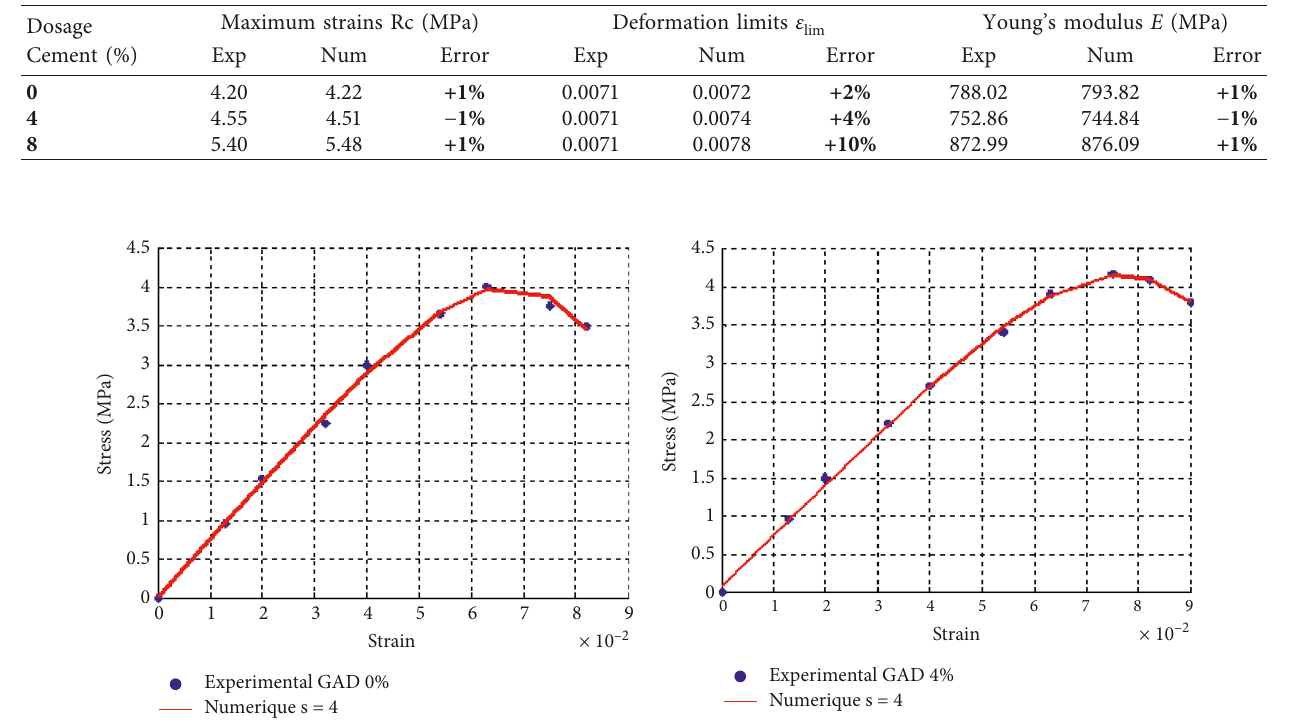
Table 3: Mechanical characteristics of BAM’s CEBs and CSEBs.